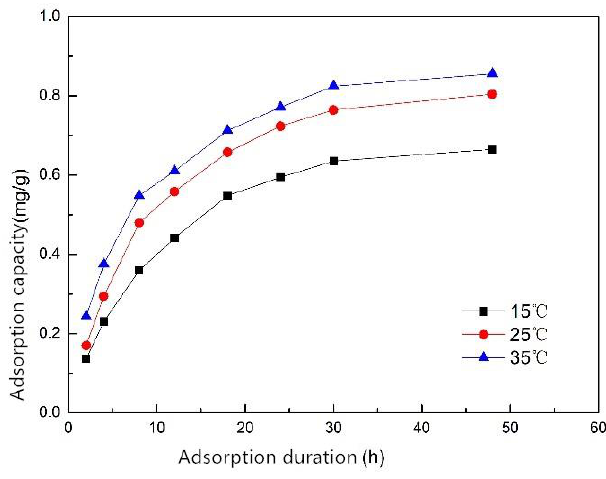
Table 4. Kinetics of phosphorus removal by ZSFB composite fiber at different temperatures.